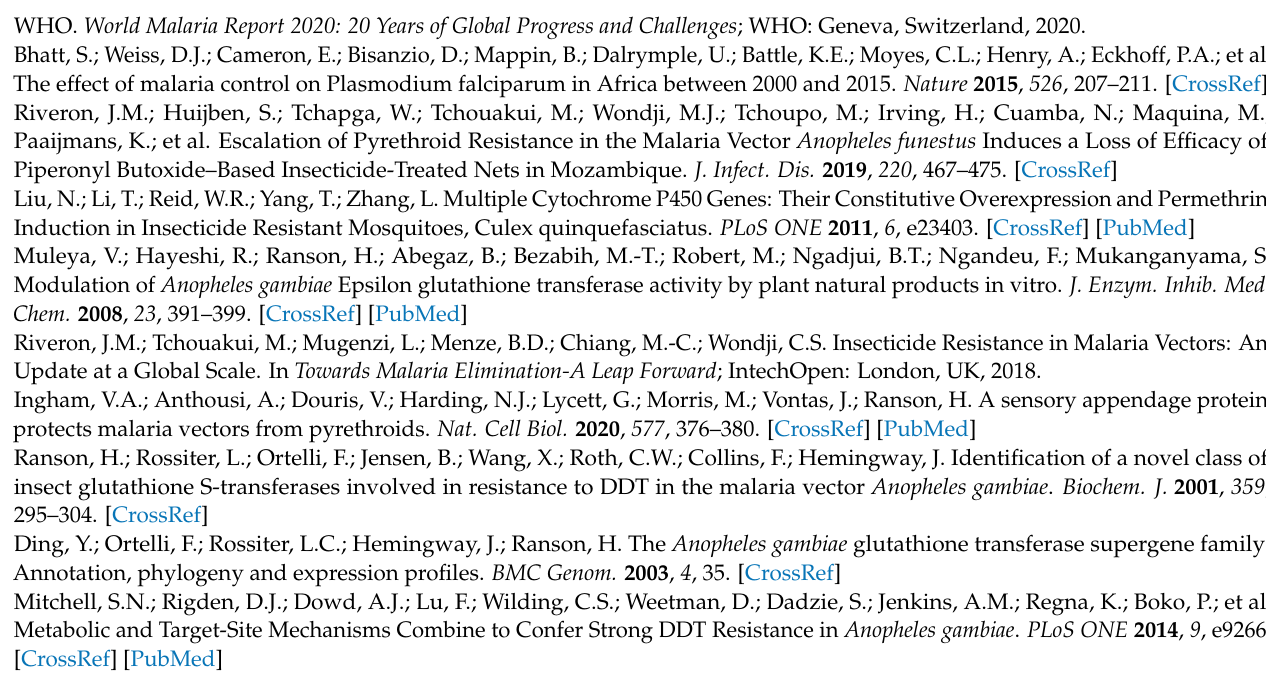
sequenc-ing). Table S1.1: Genes differentially expressed in Cameroon when comparing DDT vs Perm resistant mosquitoes, Table S1.2: Genes differentially expressed in Ghana when comparing DDT vs Perm resistant mosquitoes, Table S1.3: Genes differentially expressed in Uganda when comparing DDT vs Perm resistant mosquitoes, Table S1.4: Genes differentially expressed in Malawi when comparing DDT vs Perm resistant mosquitoes, Table S1.5: List of genes differentially over- expressed across Africa when comparing resistant population against Permethrin and DDT using RNAseq. Supplementary file 2: List of primers used. Table S2.1: list of primers used to evaluate GSTes expression profile across Africa, Table S2.2: list of primers used for double-stranded RNA